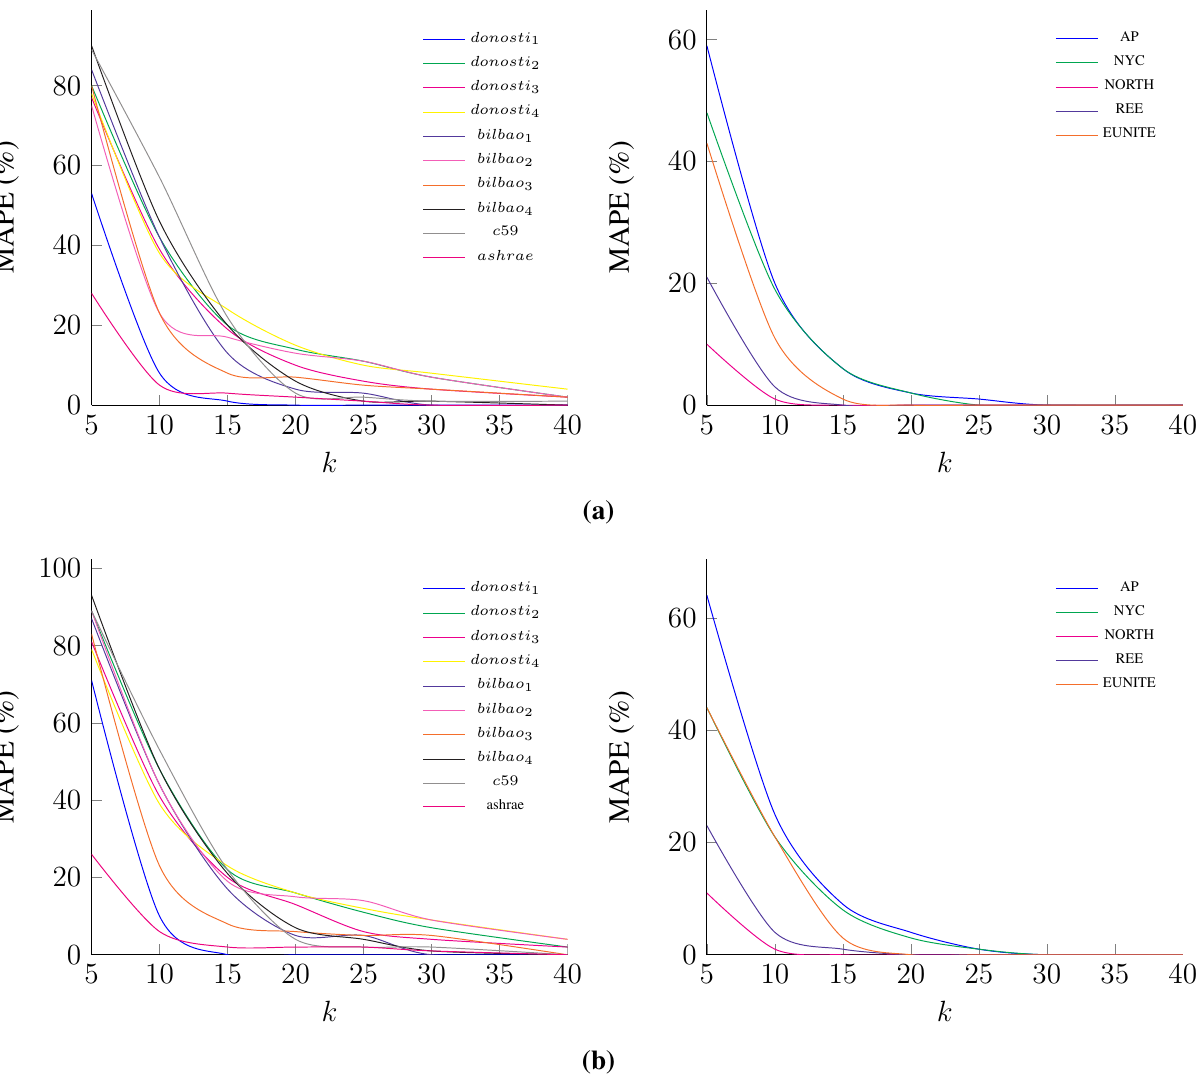
Figure 7. ( a ) Percentage of anomalous days using the AR model; ( b ) Percentage of anomalous days using the SVM